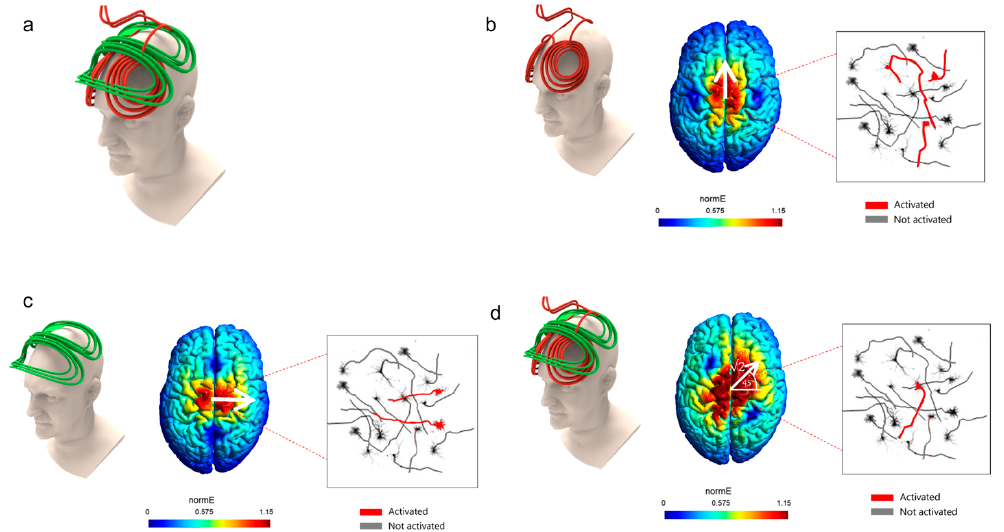
Figure 3. ( a ). Rotational field TMS coils array: two orthogonal coils one on top of the other. ( b ). With only the lower coil operated, electric field is induced along the anterior–posterior axis; thus, only neurons aligned along this axis will be activated (indicated in red). The color code indicates the field intensity (red is highest). ( c ). With only the upper coil operated, an electric field is induced along the lateral–medial axis, thus only neurons aligned along this axis will be activated (indicated in red). ( d ). With both coils operating simultaneously, electric field is induced at 45 ◦ to the lateral–medial axis; thus, only neurons aligned along this orientation will be activated (indicated in